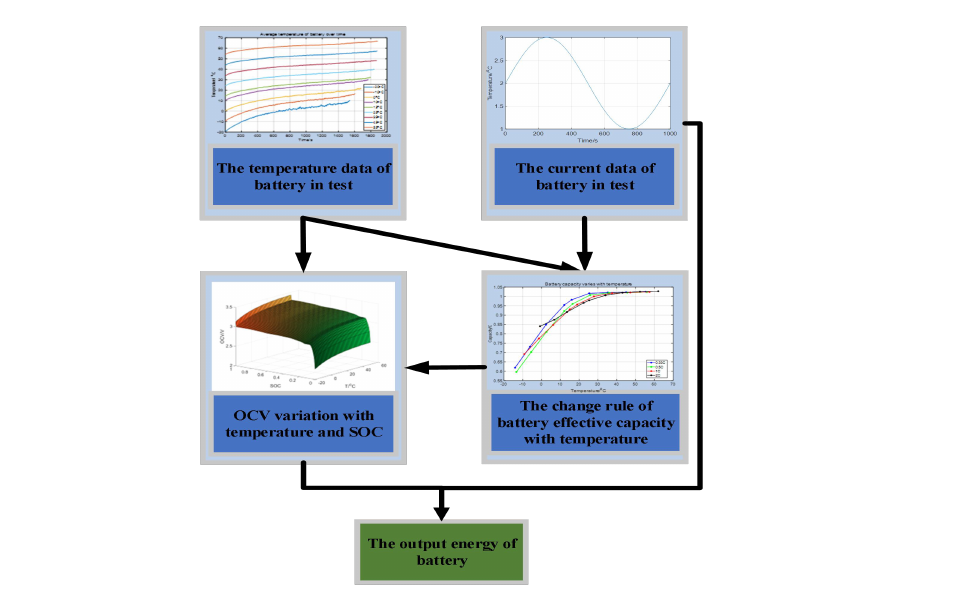
Figure 2. The flow chart of the proposed method to predict the output energy.